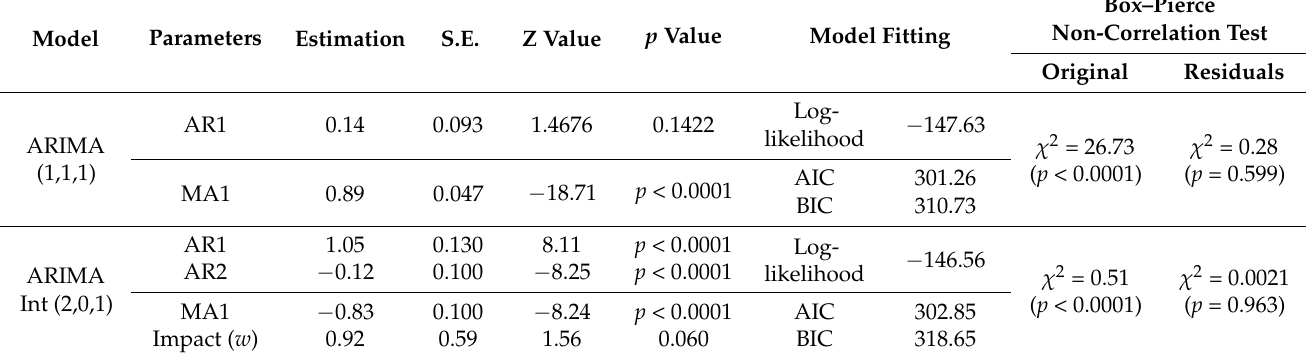
Table 3. Parameter estimation of the ARIMA and the ARIMA intervention model of rice prices